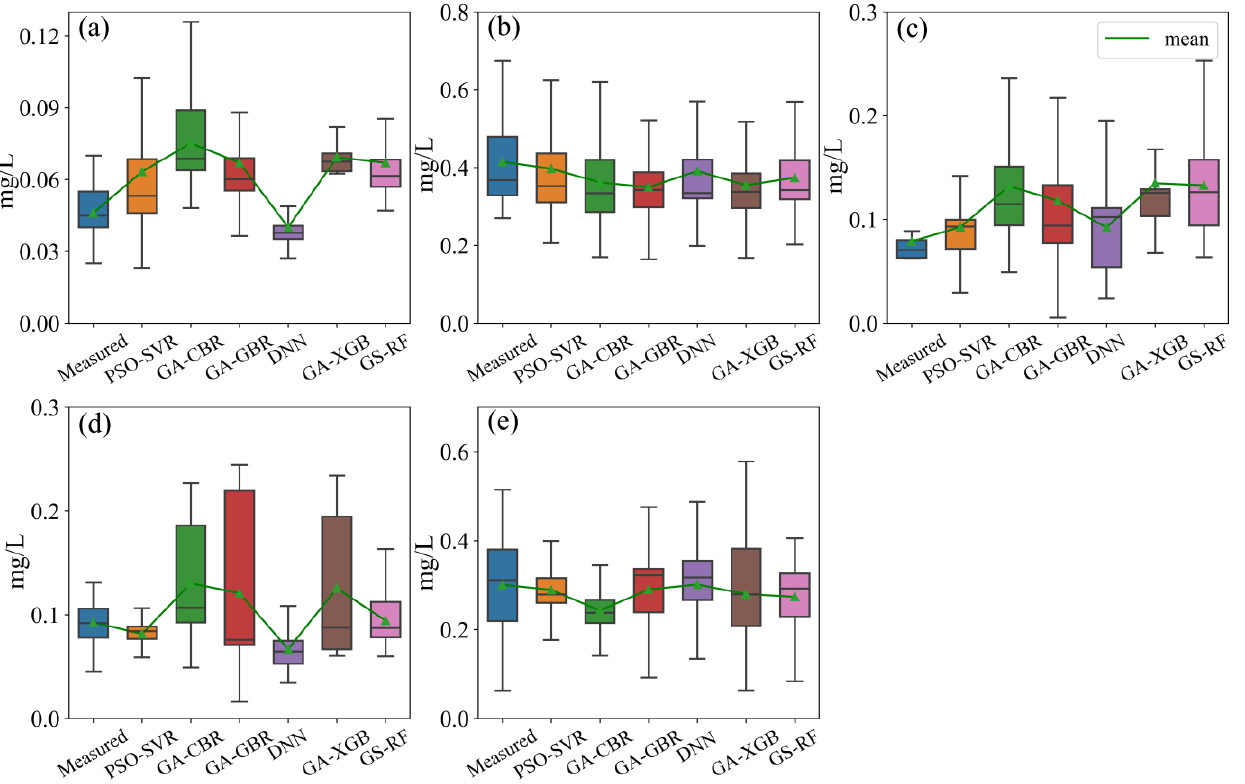
Figure 8. Statistics of measured TP concentration and derived TP concentration from the six IOA-ML models at the pixel scale: ( a ) research area A, ( b ) research area B, ( c ) research area C on 10 December 2021, ( d ) research area C on 27 May 2022, ( e ) research area C on 27 September 2022.